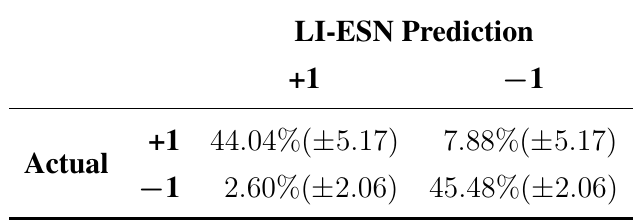
Table 3. Mean confusion matrix (expressed in % over the number of samples) on the ES2 external